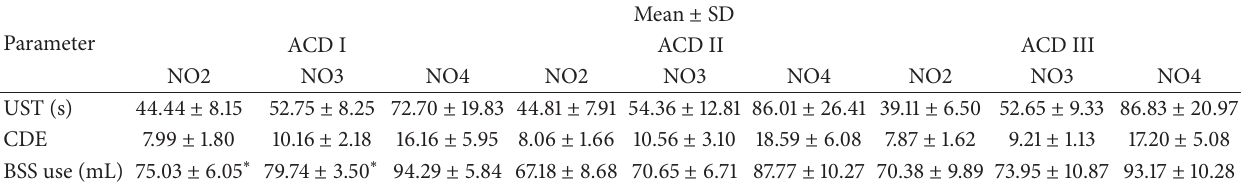
Table 2: Comparison of UST, CDE, and BSS use among three ACD groups according to cataract nucleus density. Mean ± SD Parameter ACD I ACD II ACD III NO2 NO3 NO4 NO2 NO3 NO4 NO2 NO3 NO4 UST (s) 44.44 ± 8.15